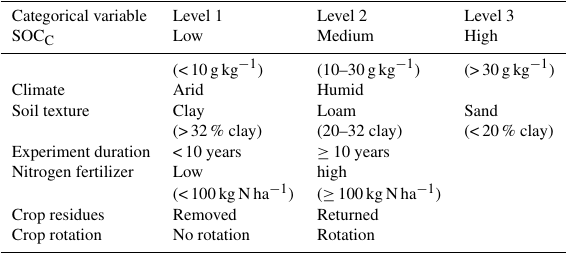
Table 2. Categories used in describing the experimental conditions. Categorical